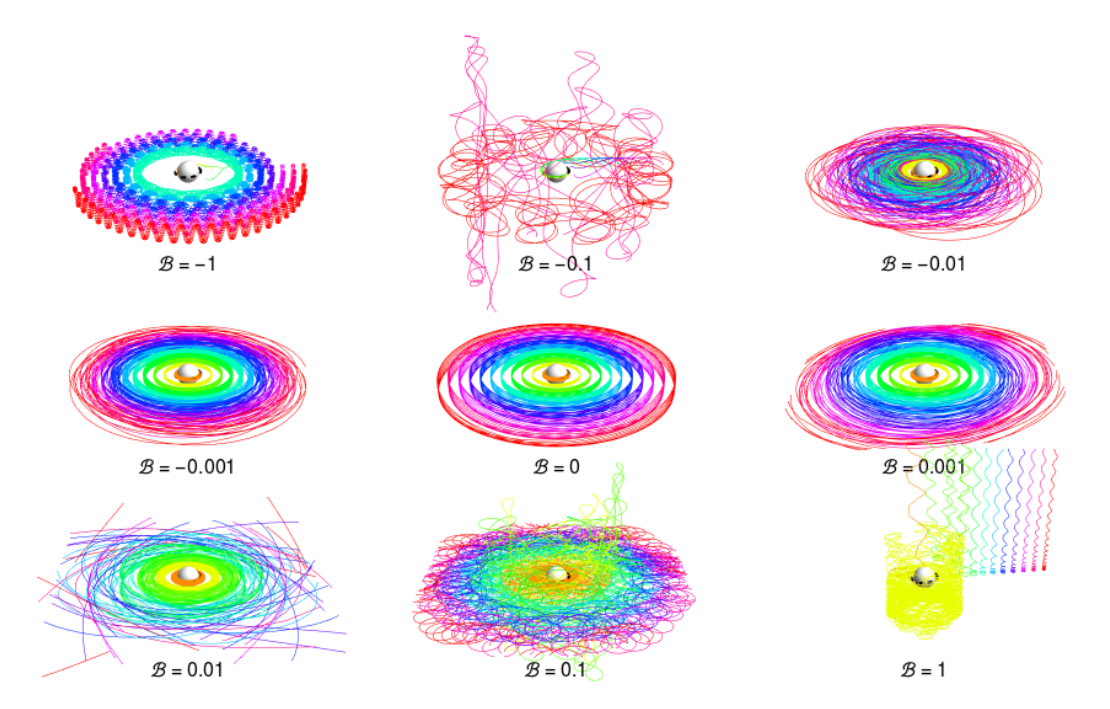
Figure 15. Thin Keplerian accretion disk around rotating Kerr BH ( a = 0.998) in uniform